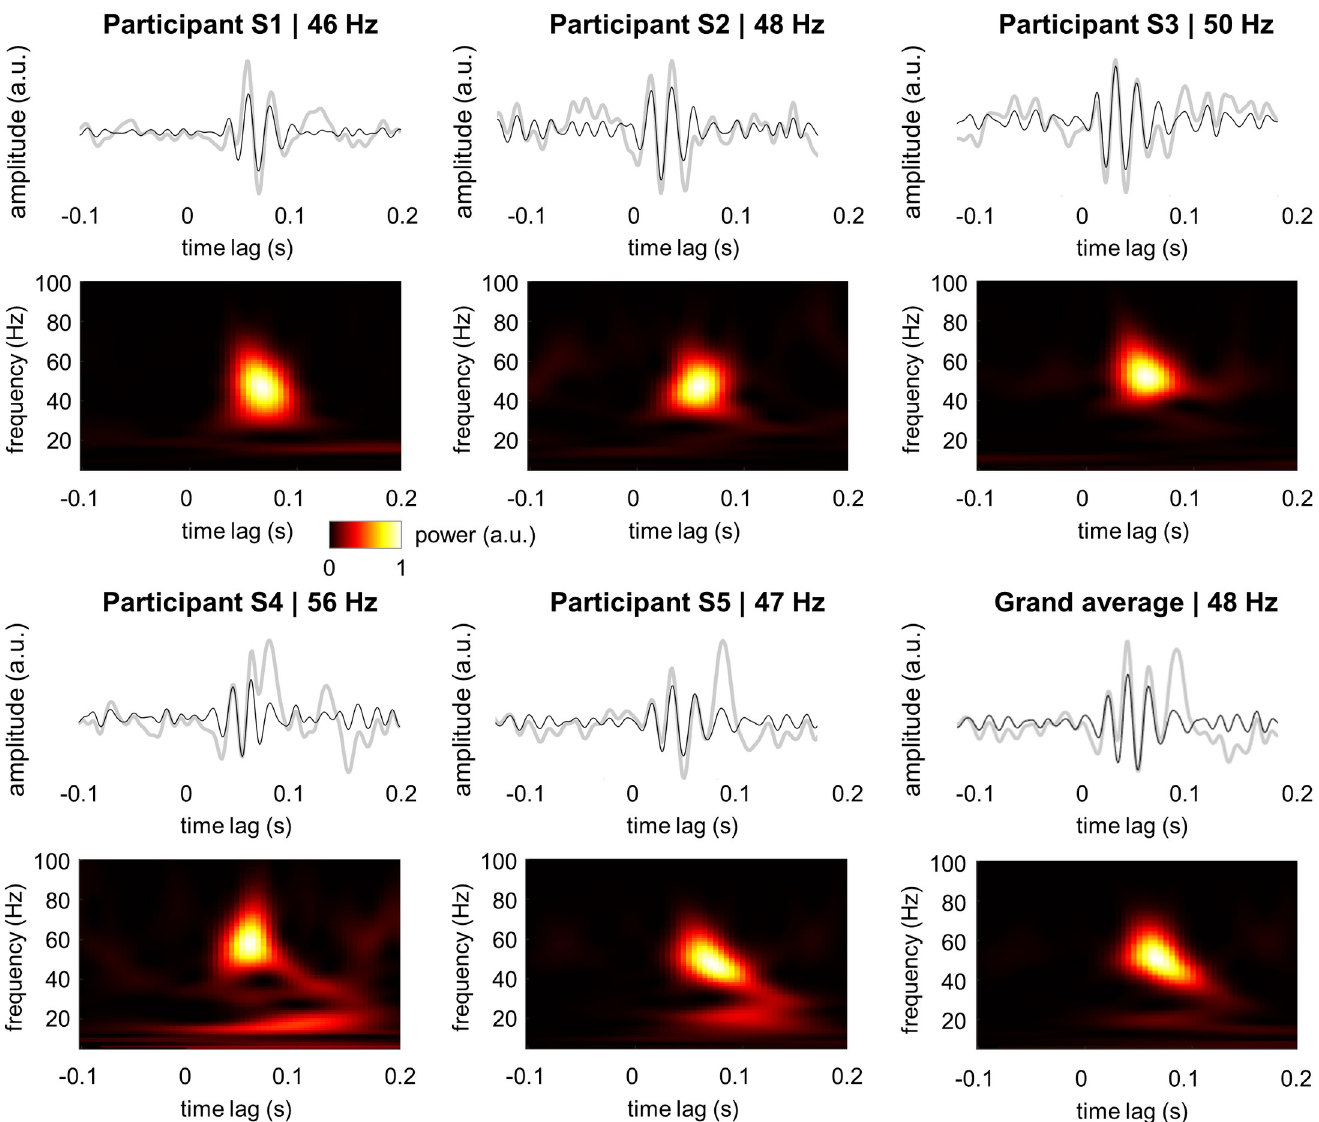
Fig 2. TRF and the associated time-frequency representation of power for individual participants. Note the robust response in 40–60 Hz gamma range. Gray lines depict the TFR at 1–100 Hz while the black lines show the response filtered at 40–100 Hz.